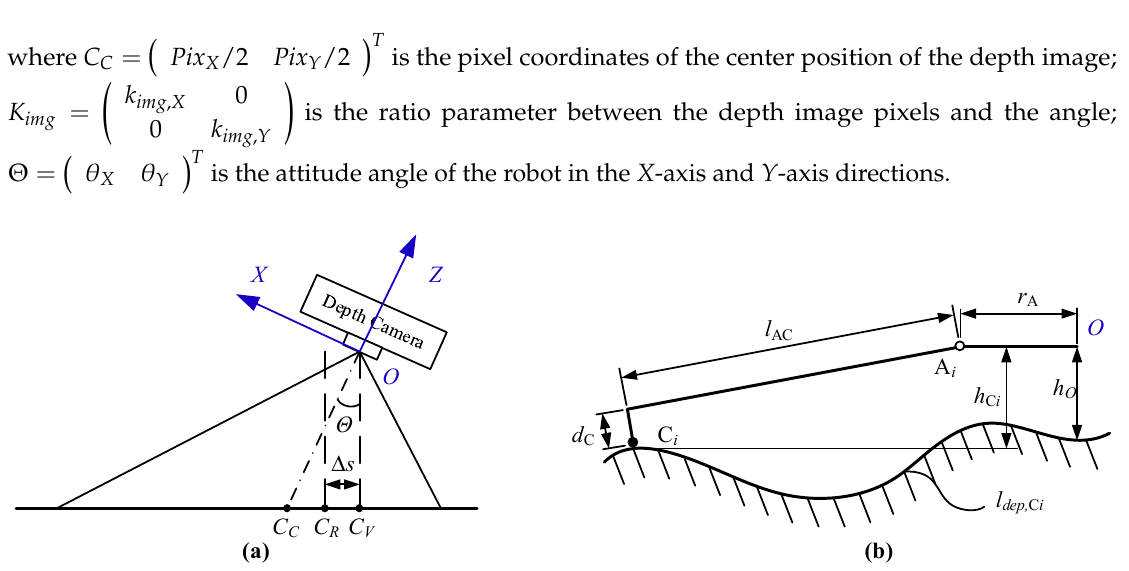
Figure 8. ( a ) Illustrations of center position analysis and ( b ) touch point analysis.